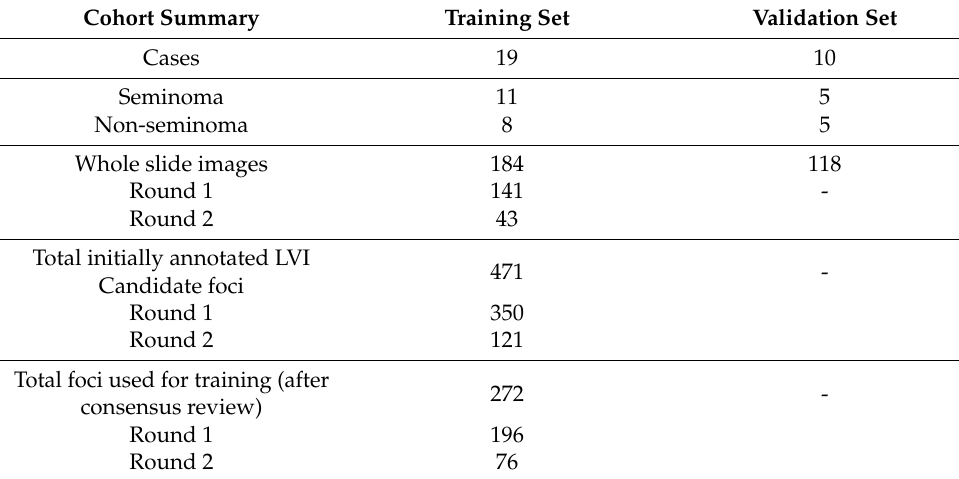
Table 1. Summary of cohort and total numbers of foci of possible lymphovascular invasion (LVI) used for training. One non-seminomatous germ cell tumour (NSGCT) case (14 whole slide images) was excluded from validation assessment following a quality check (see